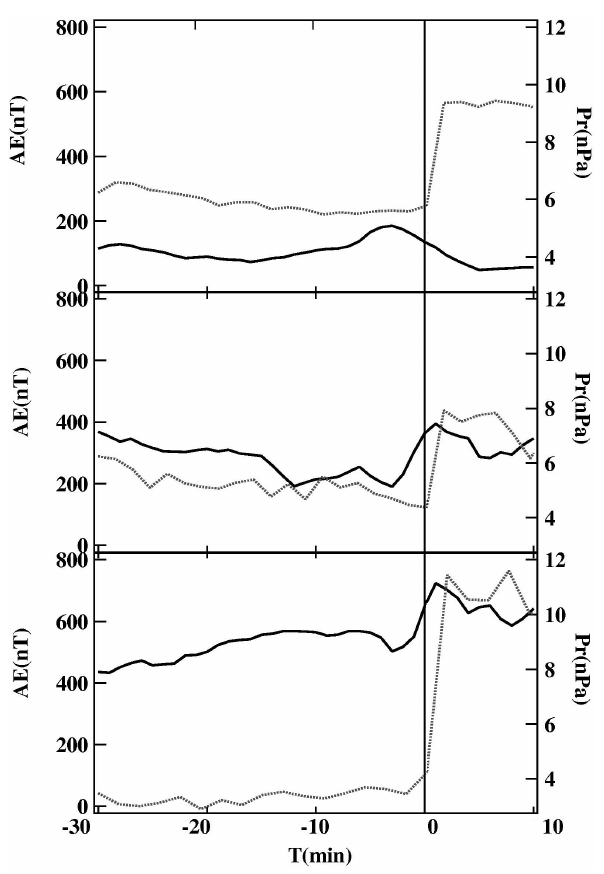
Fig. 5. Upper panel: example of Quiet event ( T WIND = 06:15 UT on 1 November 1997. T g = 06:43 UT). Middle panel: exam- ple of Intermediate event ( T WIND = 10:10 UT on 10 December 1997. T g = 11:23 UT). Lower panel: example of Disturbed event ( T WIND = 18:10 UT on 1 August 1998. T g = 18:31 UT). In all pan- els the solid curves refer to AE (vertical axis on the left), while the dotted ones refer to the solar wind dynamic pressure (vertical axis on the right). On the horizontal axis T = 0 is T g for AE and T WIND for the pressure.